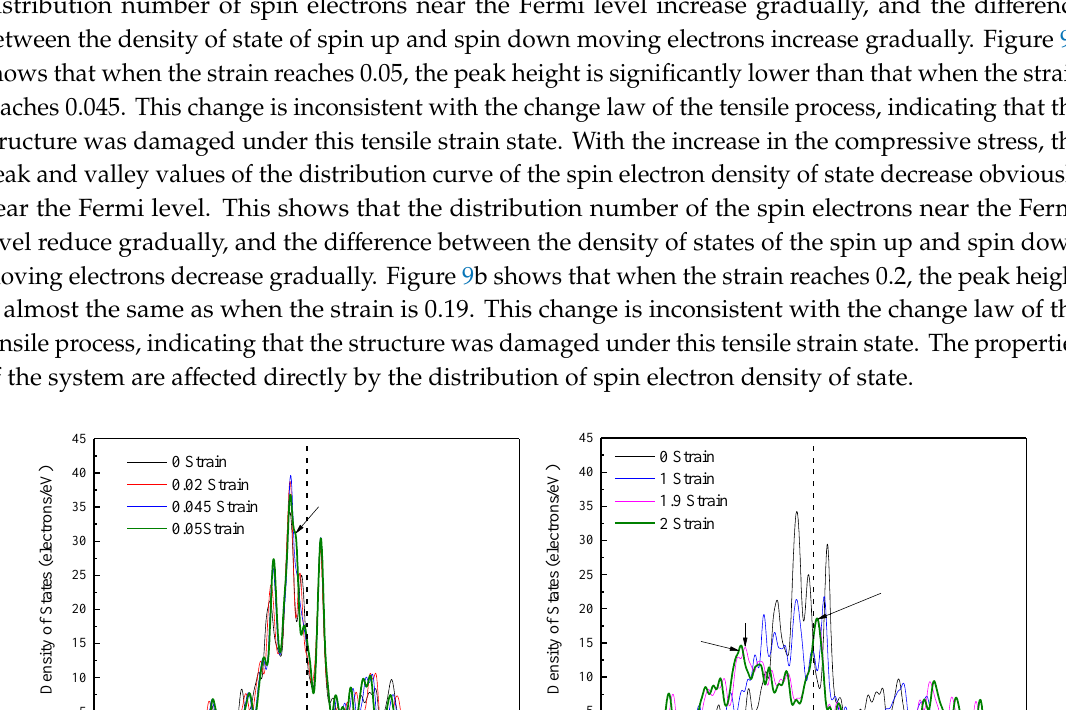
Figure 9. The change in electronic density of state in the process of tension and compression. ( a ) Tension, and ( b ) compression.